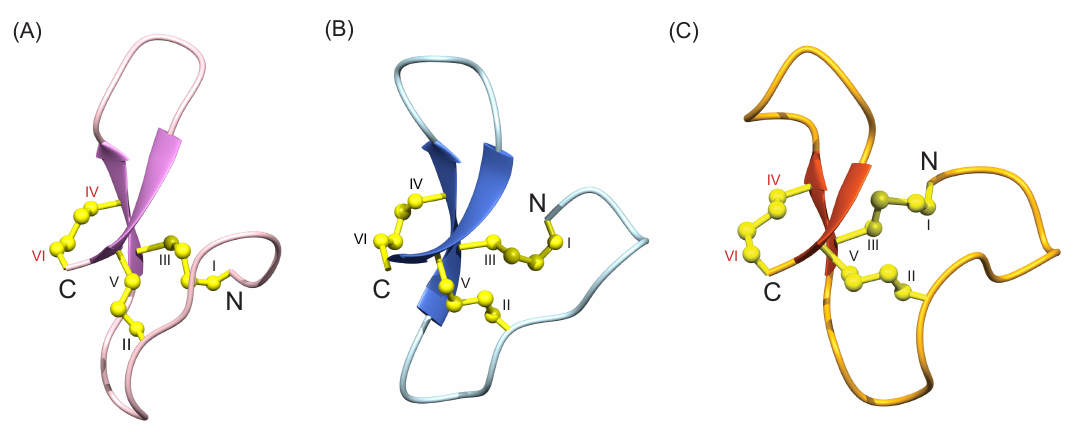
Figure 4. Three-dimensional structures of ( A ) ZF-N 24_3s , ( B ) ZF-para _3s and ( C ) Ov -GRN 12-35_3s [2] N-terminal truncated peptides. The β -hairpins are shown as arrows, and ZF-N 24_3s is shown in violet, ZF-para _3s in blue and Ov -GRN 12-35_3s (PDB: 5UJG) in orange. Disulfide bonds are shown in yellow and cysteine residues are labelled using Roman numerals. The cysteine residues involved in forming the disulfide bond (IV-VI) not present in the full-length granulin structures of zebrafish granulin AaE and by homology Ov -GRN-1, are labelled with red letters ( A , C ). The figure was prepared using MOLMOL [29].